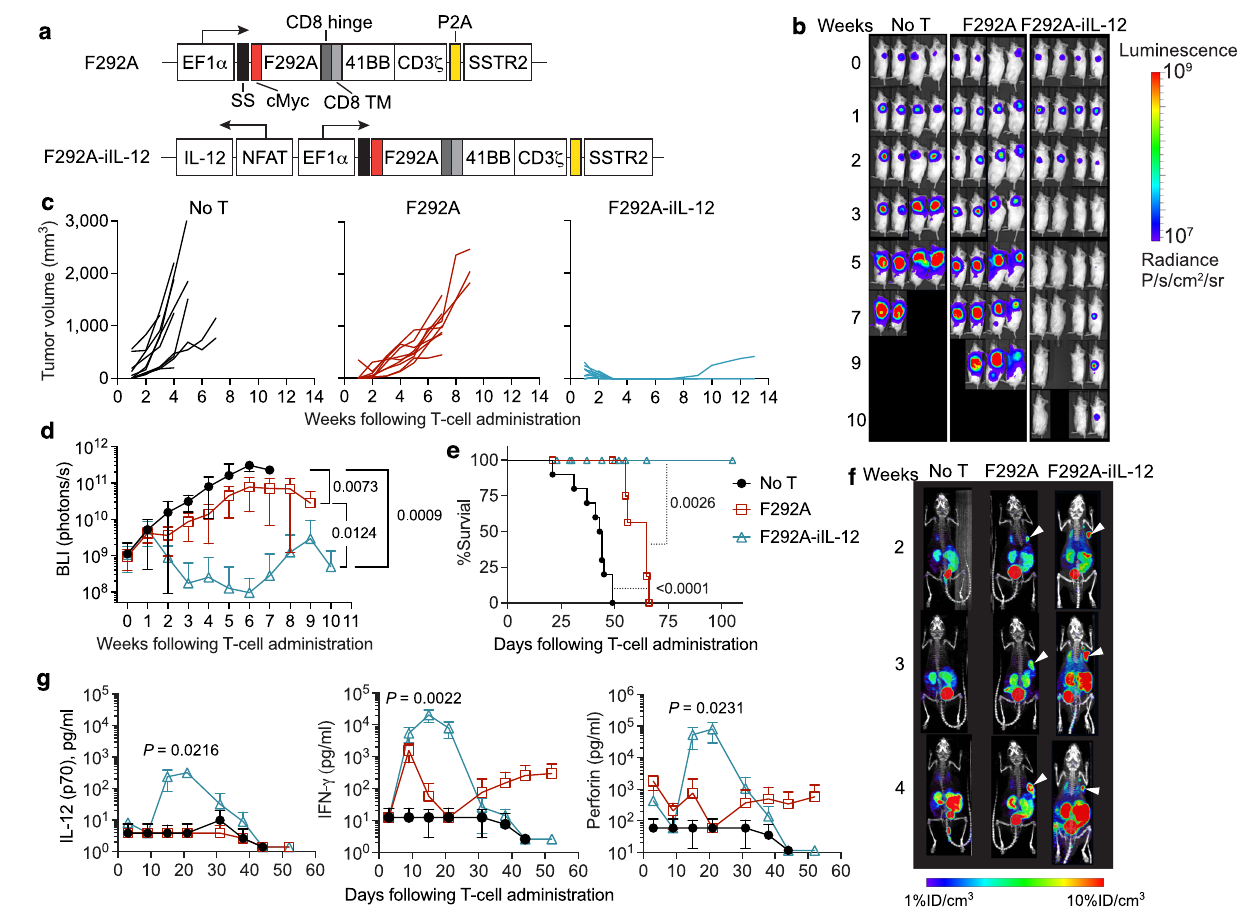
Fig. 6 | Enhanced activity of IL-12-armored ICAM-1-speci fi c CAR-T cells in an anaplasticthyroidcancermodel.a LentiviralvectorsencodingF292AandF292A- iIL-12CARs. b – g NSGmicewereinoculatedwith1×10 6 8505Ccellssubcutaneously and treated 5 days later with 1 × 10 7 F292A or F292A-iIL-12 CAR-T cells by intrave- nous injection or left untreated (No T). b Representative bioluminescence images ( n =4 mice/group). c – e , Tumor volume measurements for individual mice ( c ), average whole-body BLI kinetics ( d ), and Kaplan – Meier survival curve ( e ). No T, n =10 mice examined over 4 independent experiments; F292A, n =10 mice